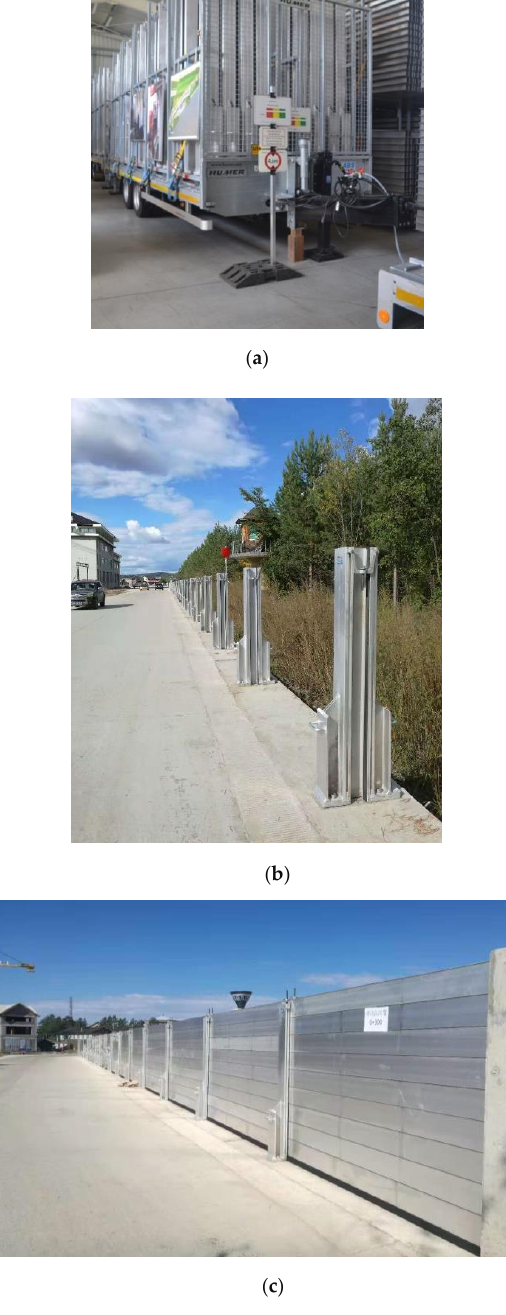
Figure 3. Removable floodwall storage and install. ( a ) Prefabricated parts received and stored in the warehouse, ( b ) install the center post, and ( c ) install all the parts.